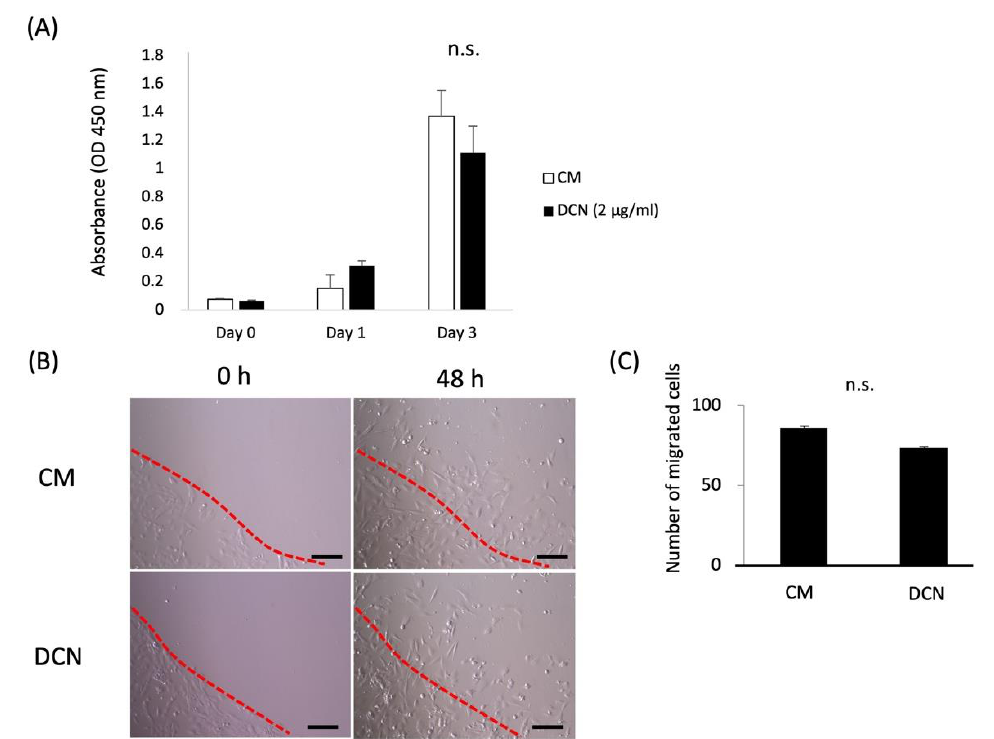
Figure 5. Effects of DCN on the proliferation and migration of HPDLSCs. ( A ) HPDLSCs were cultured in 10% FBS/ α -MEM (CM) or CM on a 2 µ g/mL DCN coating (DCN) for 0, 1, and 3 days. A proliferation assay was performed using the WST-1 proliferation assay kit at an absorbance of 450 nm. ( B ) Migration of HPDLSCs was analyzed by a ring cell migration assay. HPDLSCs were cultured in CM or DCN for 48 h, and then migrated cells were counted. Dotted lines delineate the ring edges. Bars = 200 µm ( C ) The graph shows the quantification of migrated cells. Values are the average of three random fields per well. n.s. = no significance.